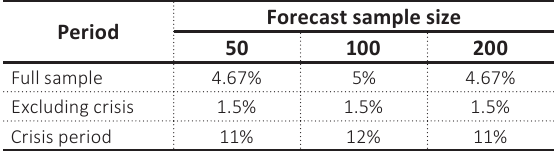
Table 3. Average rejection rate in each period